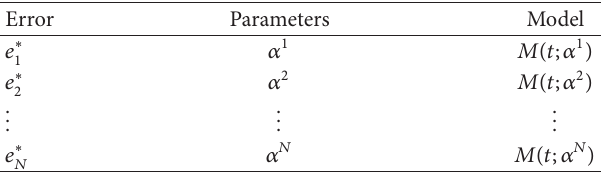
Table 4: Model fitting to 𝑁 samples of the data’s probability